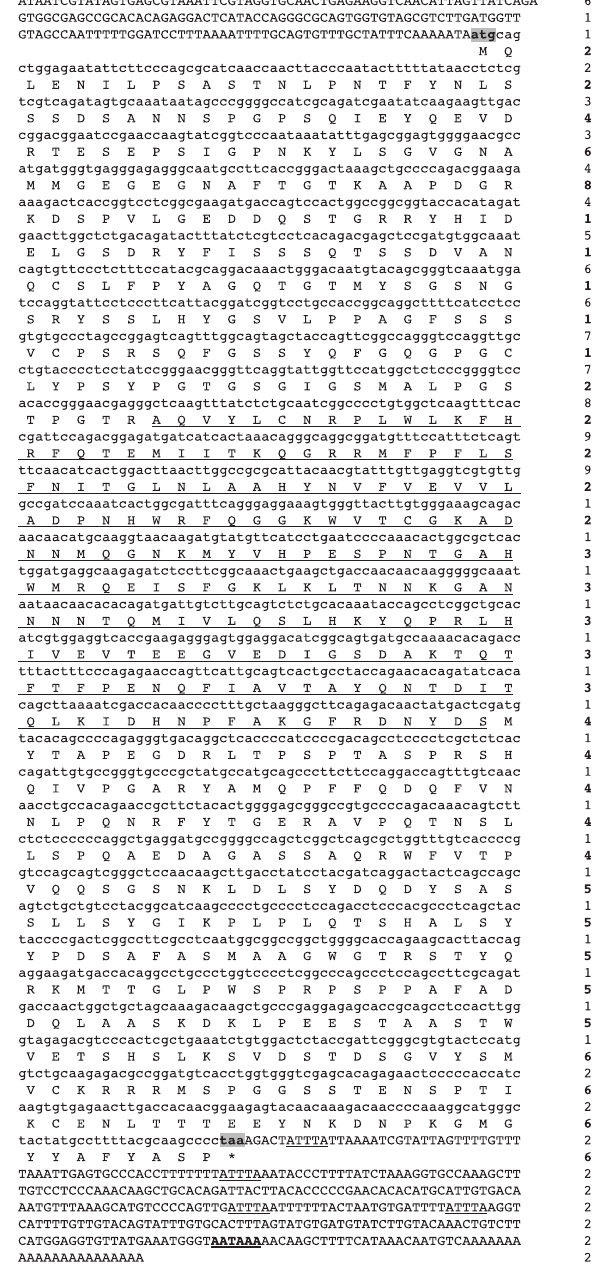
Figure 1. Nucleotide and deduced amino acid sequence of Atlantic salmon Eomes cDNA. Uppercase denotes the UTR’s and lowercase denotes the coding regions. The T-box domain is underlined. Start and stop codons are shaded and marked with bold letters. The asterisk indicates the stop codon. The RNA instability motif (ATTTA) is underlined. The putative polyadenylation signal is bold and underlined. doi:10.1371/journal.pone.0055893.g001 (A) tail in the 3 9 UTR. The putative Eomes protein in Atlantic salmon was predicted to be 650 aa with a molecular weight of 71 kDa and pI of 6.37. The conserved T-box DNA binding domain consisted of 194 aa (Figure1).